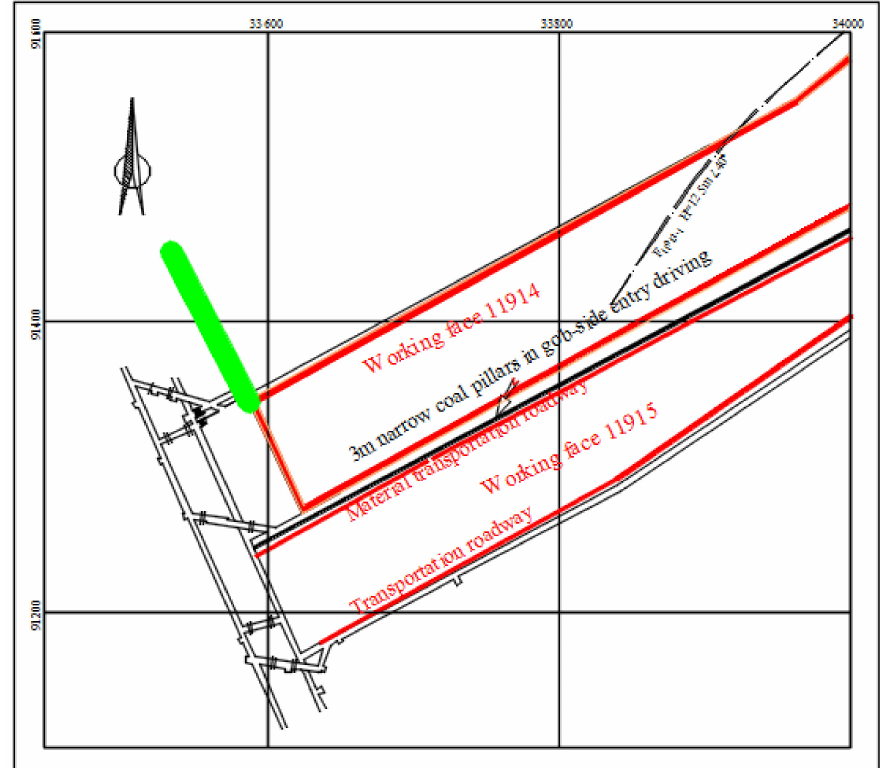
Figure 1. Layout of the 11915 working face.